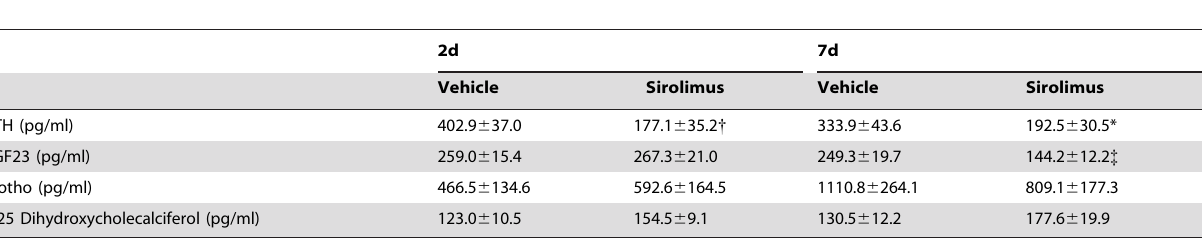
Table 2. Serum values of phosphate regulatory hormones from vehicle and sirolimus-treated rats after two and seven days of